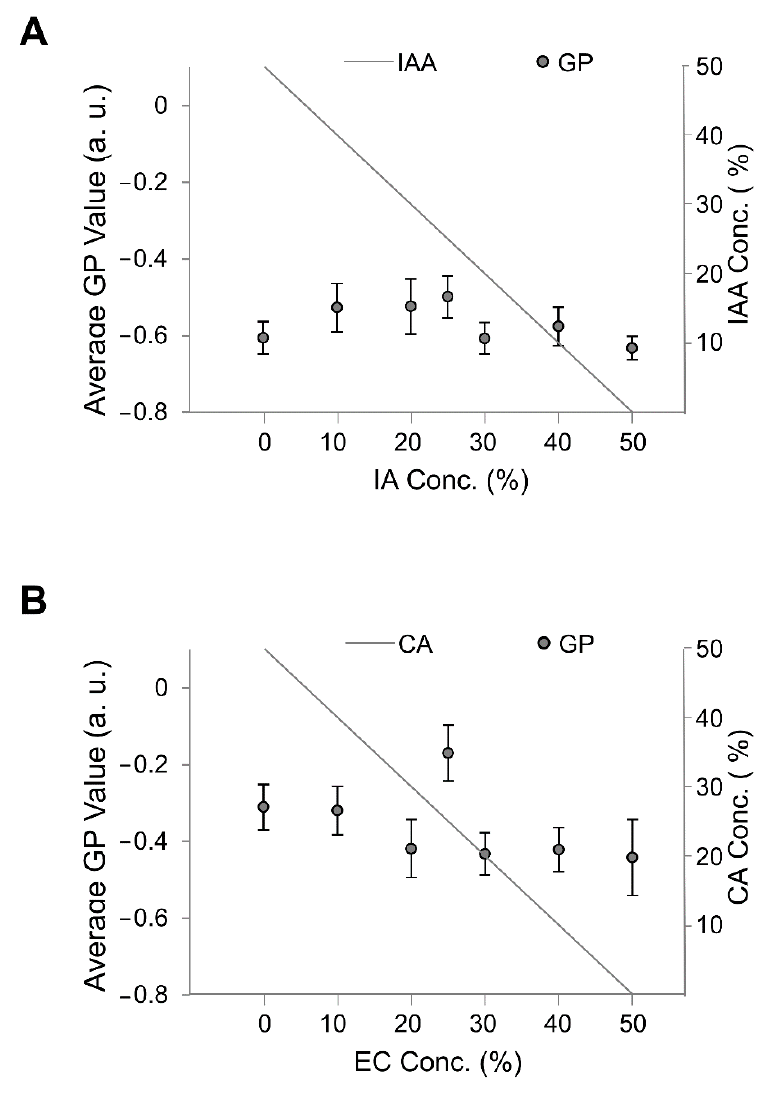
Figure 9. Average GP values of membranes containing different flavors. The total flavor concentration was constant at 50%, and the flavor ‐ to ‐ precursor ratio was variable. ( A ) Diameters of vesicles containing isoamyl acetate (IA) and isoamyl alcohol (IAA). ( B ) Diameters of vesicles containing ethyl caproate (EC) and caproic acid (CA).